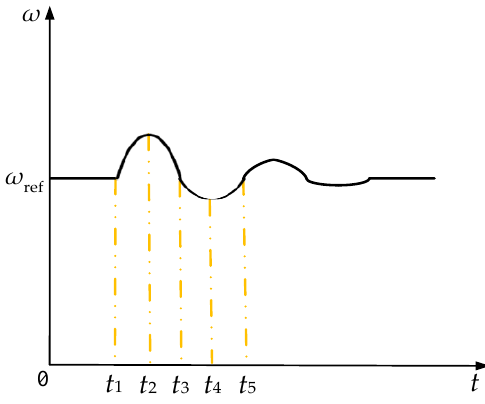
Figure 8. Transient angular frequency curve.